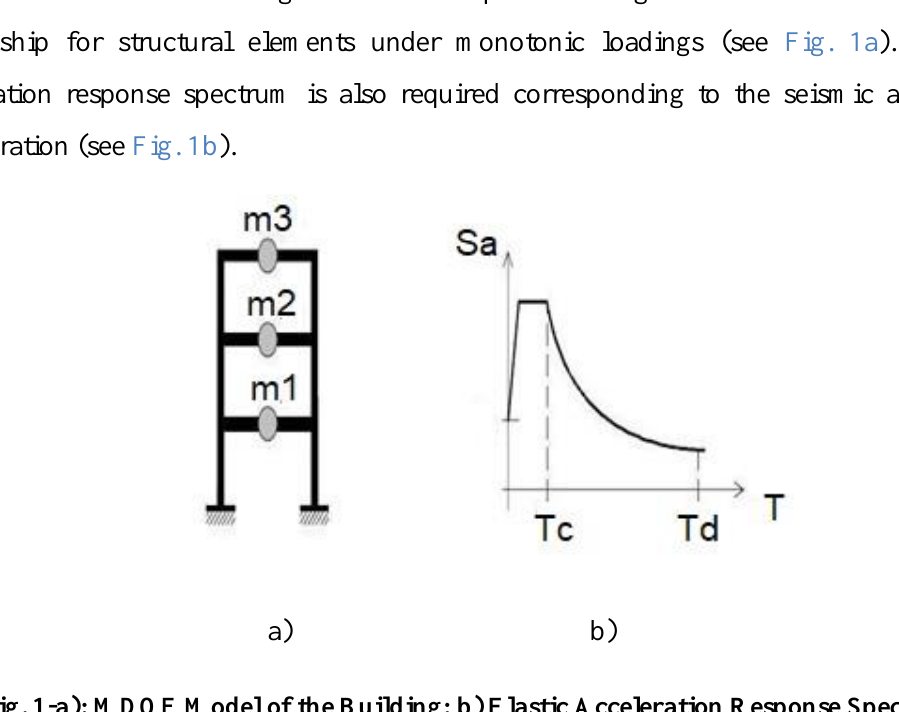
Fig. 1-a): MDOF Model of the Building; b) Elastic Acceleration Response